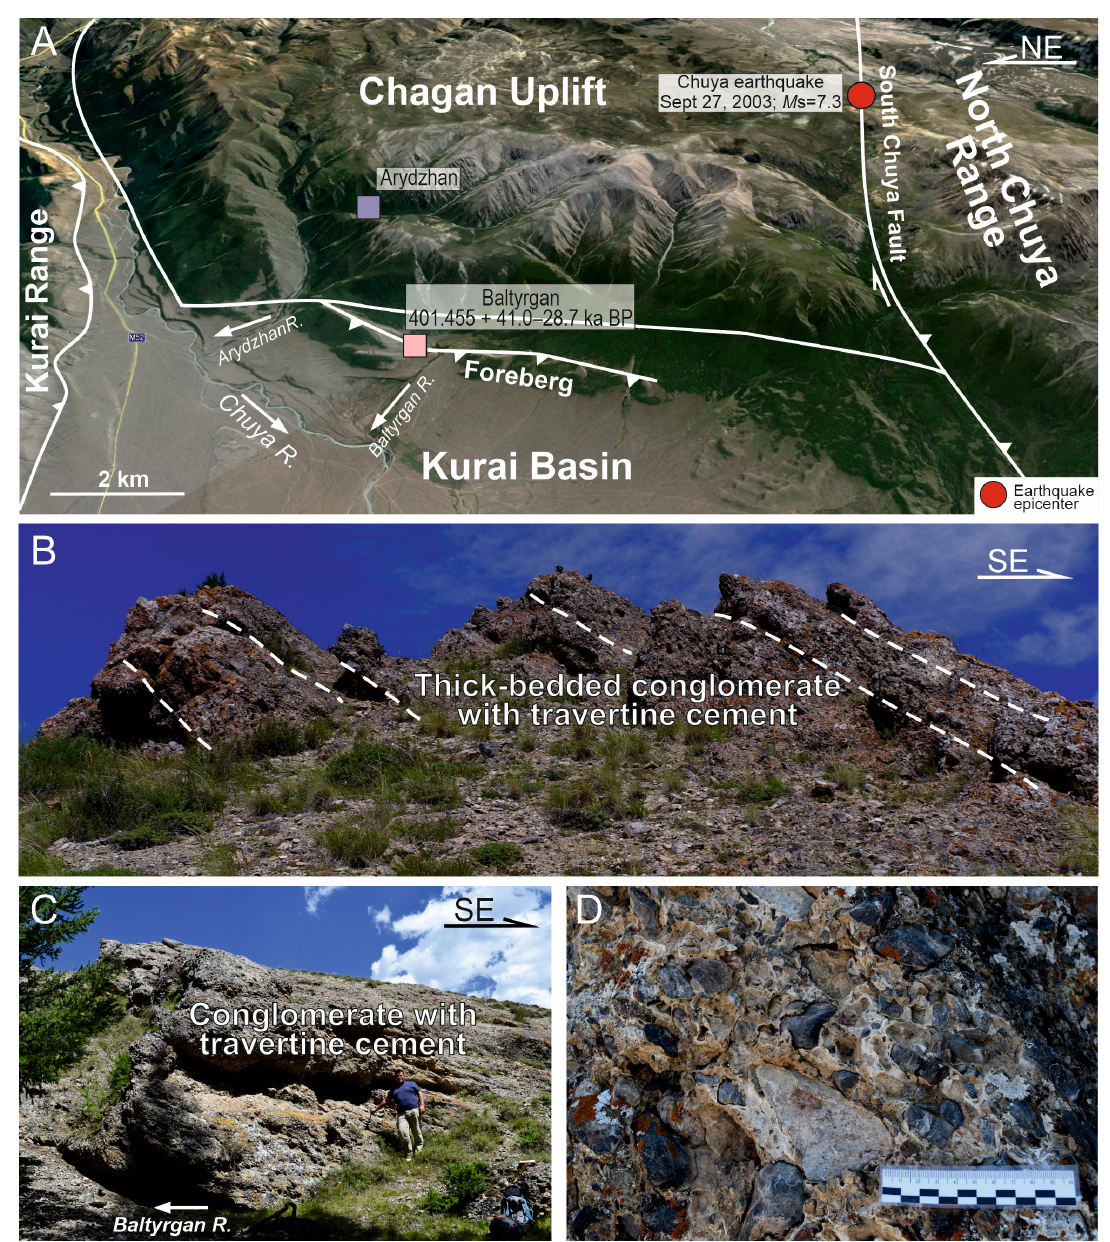
Figure 8. Location and morphology of the Baltyrgan travertines. ( A ) Active faults, location, and U-Th dates of the Baltyrgan travertines (50.157524° N, 88.023709° E). ( B ) Inclined thick-bedded conglomerates with travertine cement. ( C , D ) Conglomerates with travertine cement.